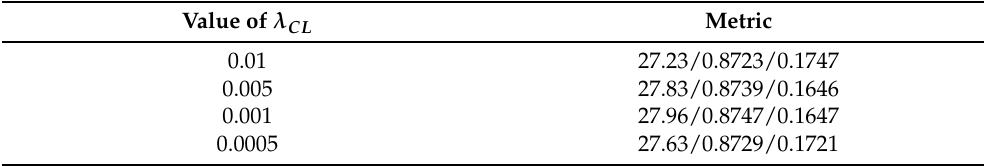
Table 6. Metric values (PSNR/SSIM/LPIPS) of the proposed PHMNet trained with different λ CL hyperparameters. It is noted that other hyperparameters are fixed.